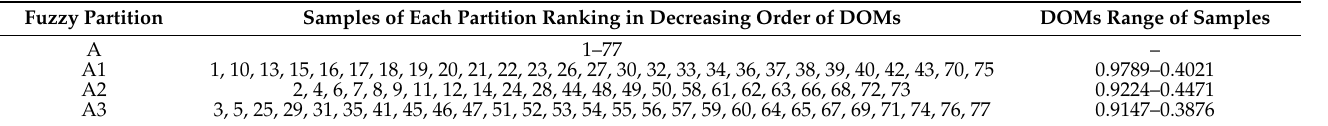
Figure 3. kNN modeling of mushroom samples, with three features selected and five neighbors. Table 2. The three fuzzy partitions obtained by applying the fuzzy c-means clustering